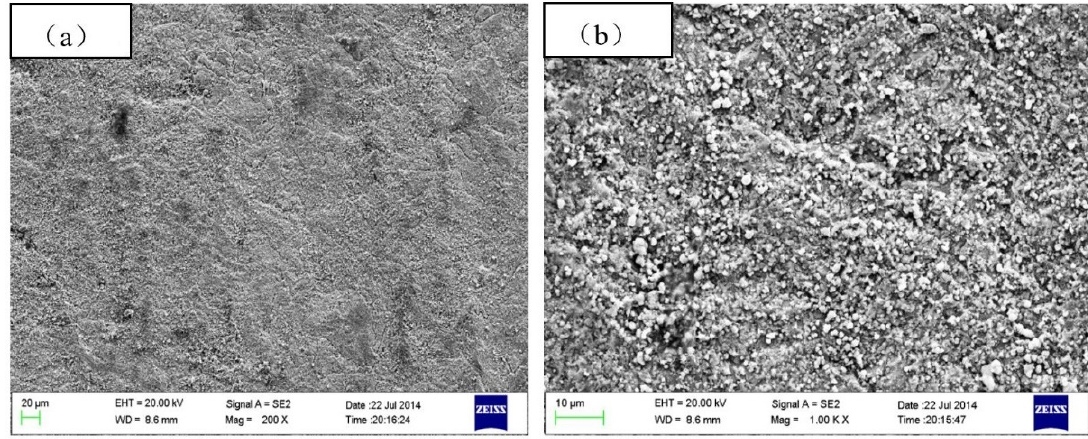
Figure 3 . The SEM morphology of corrosion products after 1.5 years exposure: ( a ) 200×; ( b ) 1000×.